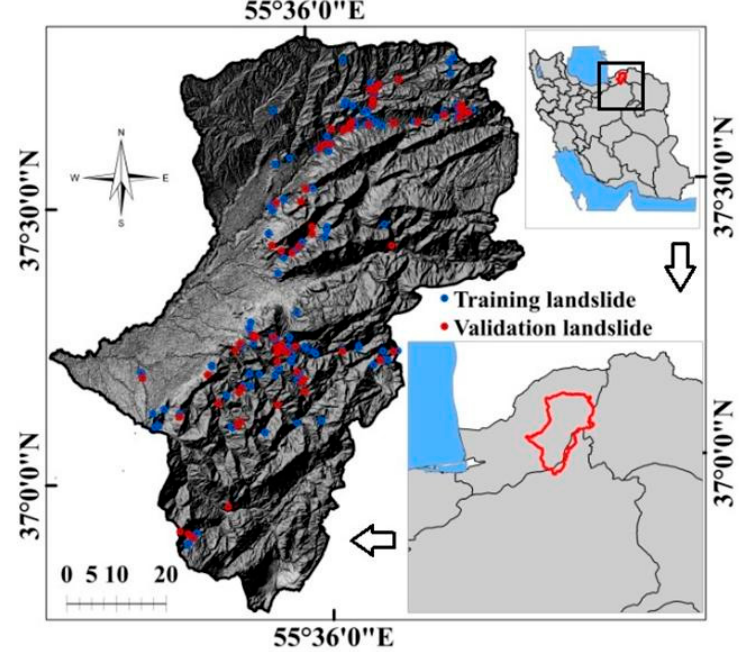
Figure 1. Location of the study area.